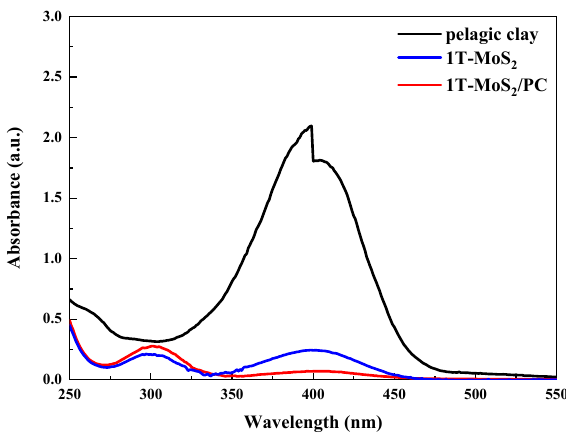
Figure 7. UV–vis absorption spectra of catalytic reduction of 4-NP with NaBH 4 over pelagic clay, 1T-MoS 2 and 1T-MoS 2 /PC at a solid/liquid ratio of 3 g/L. (The initial concentration of 4-NP was 0.12 mmol/L).